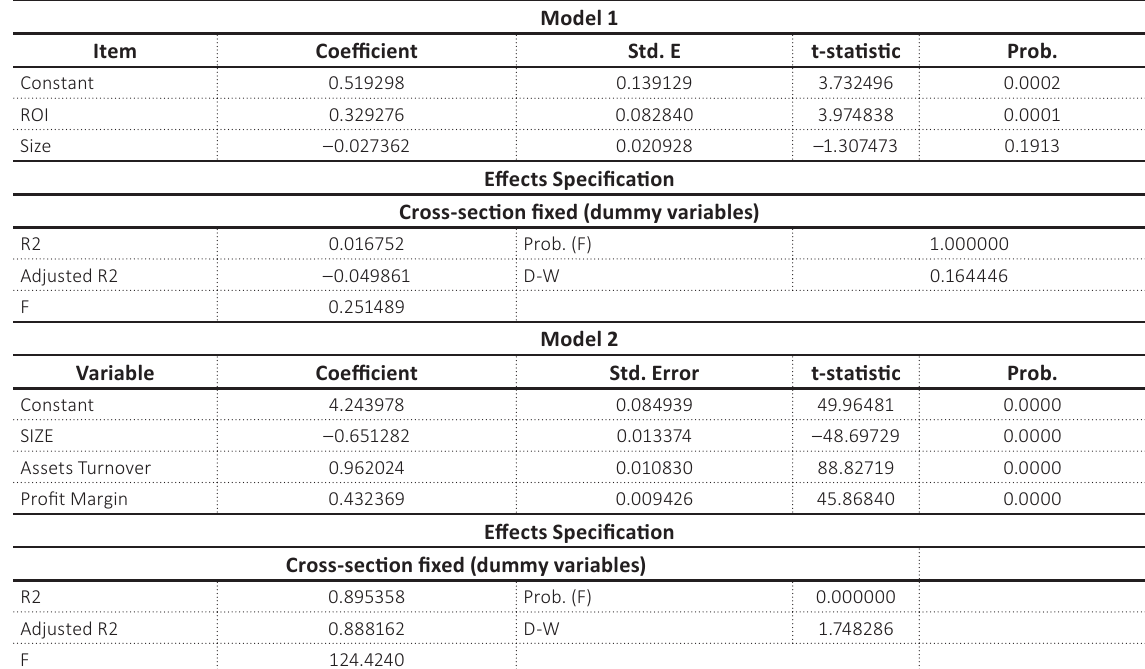
Table 10. Random effect model